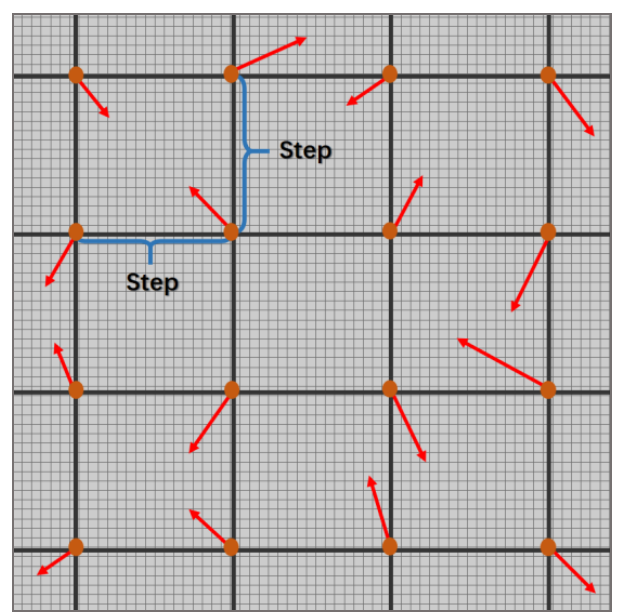
Figure 11. Gradient field based on sample steps.